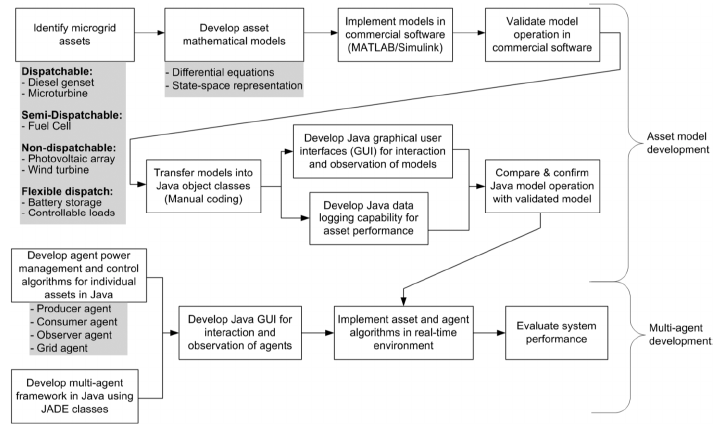
Figure 5. Simulation roadmap for a MAS-based decision system.